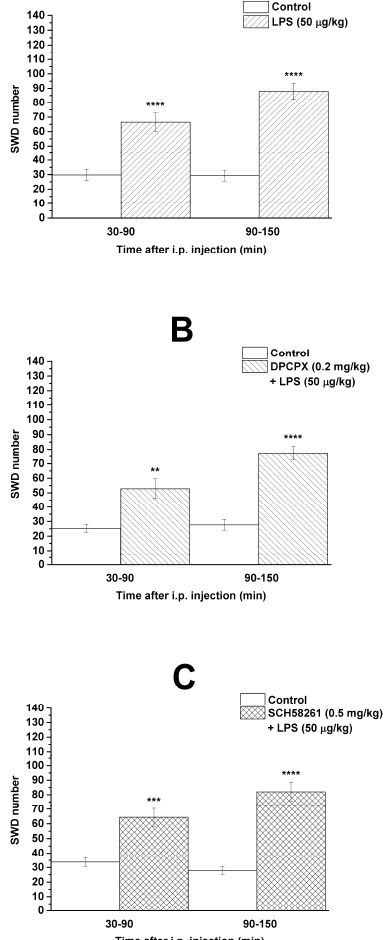
Figure 2. Effect of LPS (50 µ g/kg) alone ( A ) and combined administration of DPCPX (0.2 mg/kg) with LPS ( B ) and SCH58261 (0.5 mg/kg) with LPS ( C ) on SWD number (group 1, group 2 and group 3, respectively). Abbreviations: DPCPX, 1,3-dipropyl-8-cyclopentylxanthine; i.p., intraperitoneal; LPS, lipopolysaccharide; SCH582361, 7-(2-phenylethyl)-5-amino-2-(2-furyl)-pyrazolo-[4,3-e]-1,2,4- triazolo[1,5 ‐ c]pyrimidine; SWD, spike ‐ wave discharge. **: p < 0.01, ***: p < 0.001 and ****: p < 0.0001. Table 1. Effect of LPS alone, and combined administration of DPCPX with LPS and SCH58261 with LPS on SWD number. Figure 2A (Group 1) Figure 2B (Group 2) Figure 2C (Group 3) Treatments